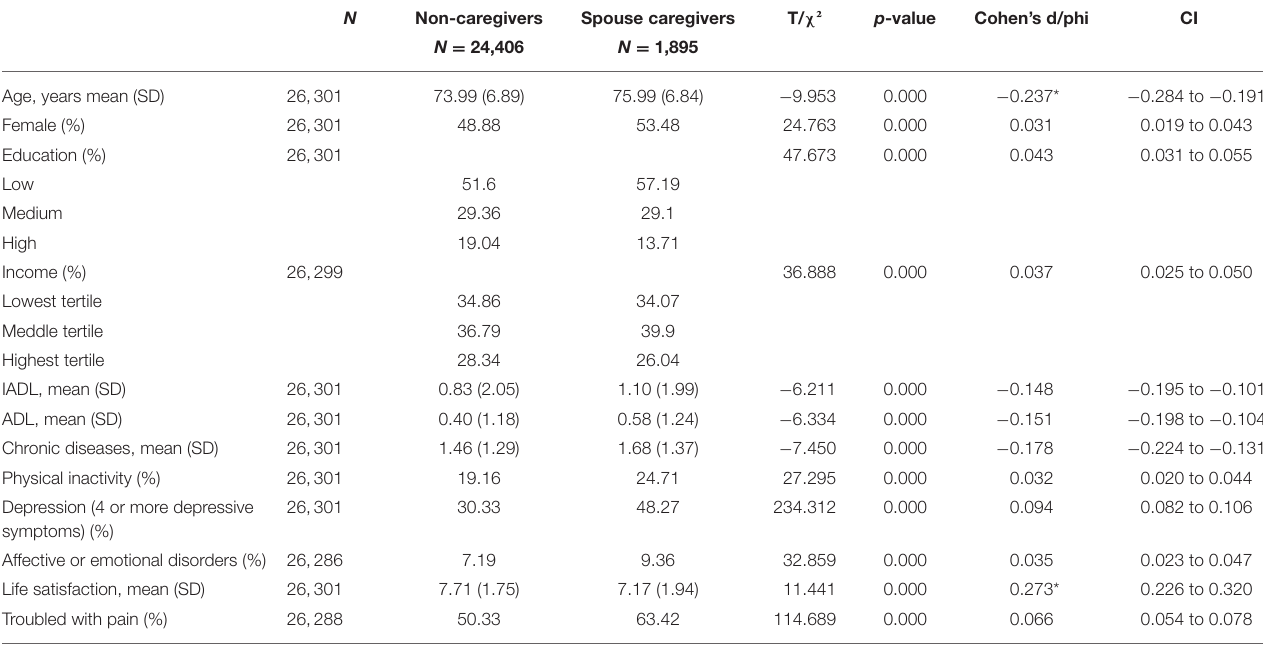
TABLE 1 | Descriptive statistics of European older adults aged 65 + , according to caregiver status. N Non-caregivers Spouse caregivers T/ χ